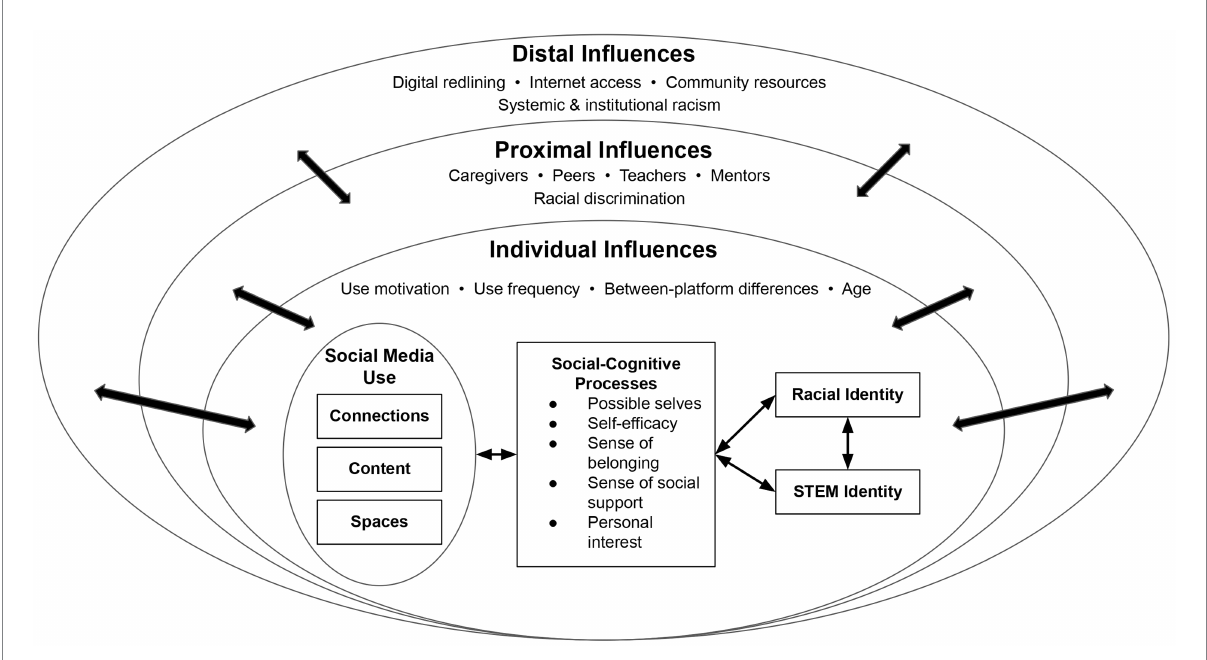
FIGURE 1 Conceptual model illustrating associations between offline influences, social media use, and racial and STEM identity